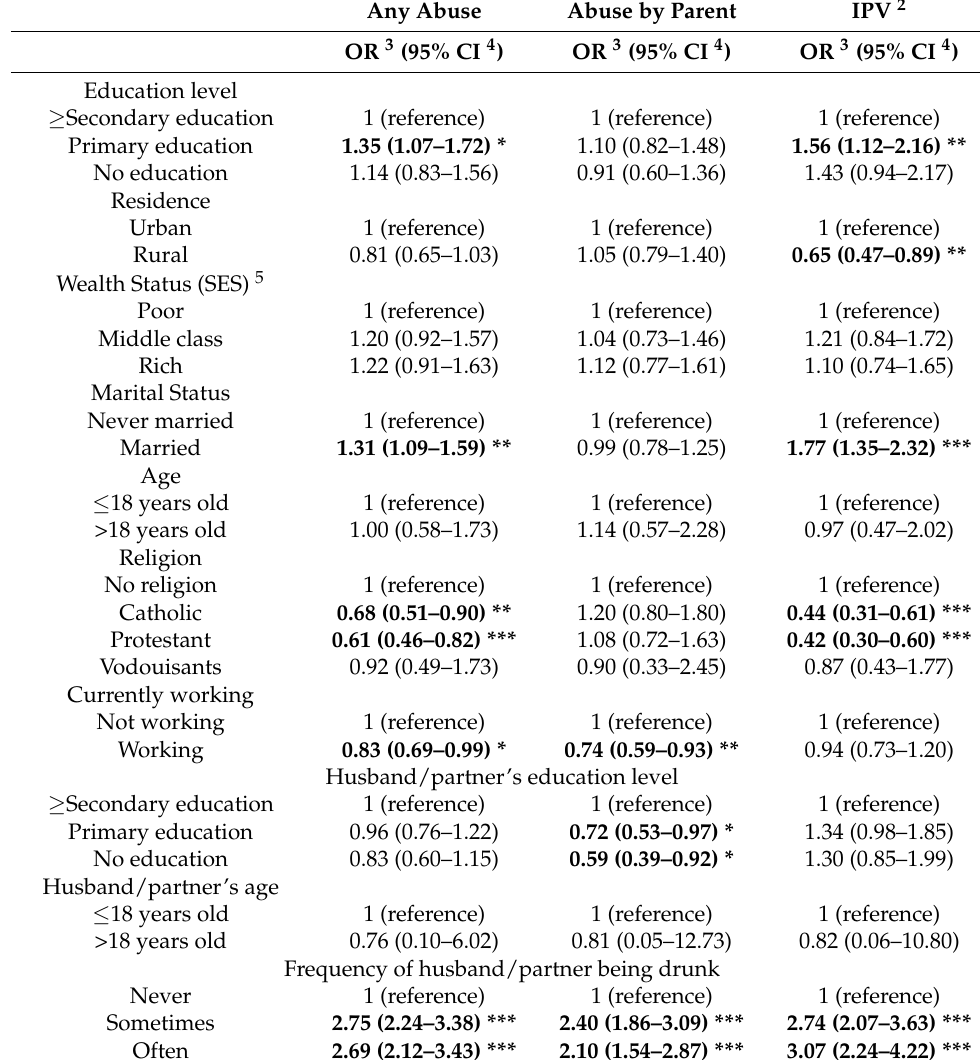
Table 3. Sociodemographic characteristics of Haitian women exposed to domestic abuse by parents or by intimate partner 1